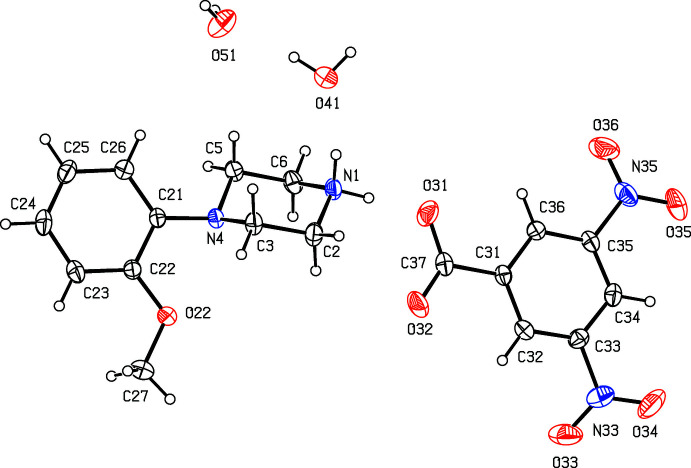
The independent components of compound (XI) showing the atom-labelling scheme. Displacement ellipsoids are drawn at the 30% probability level.